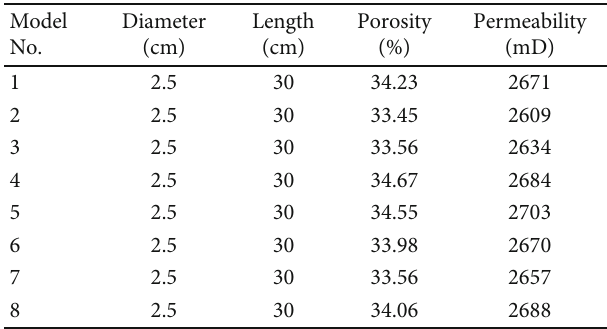
Figure 2: Schematic diagram of foam blocking. Table 1: Experimental parameters for